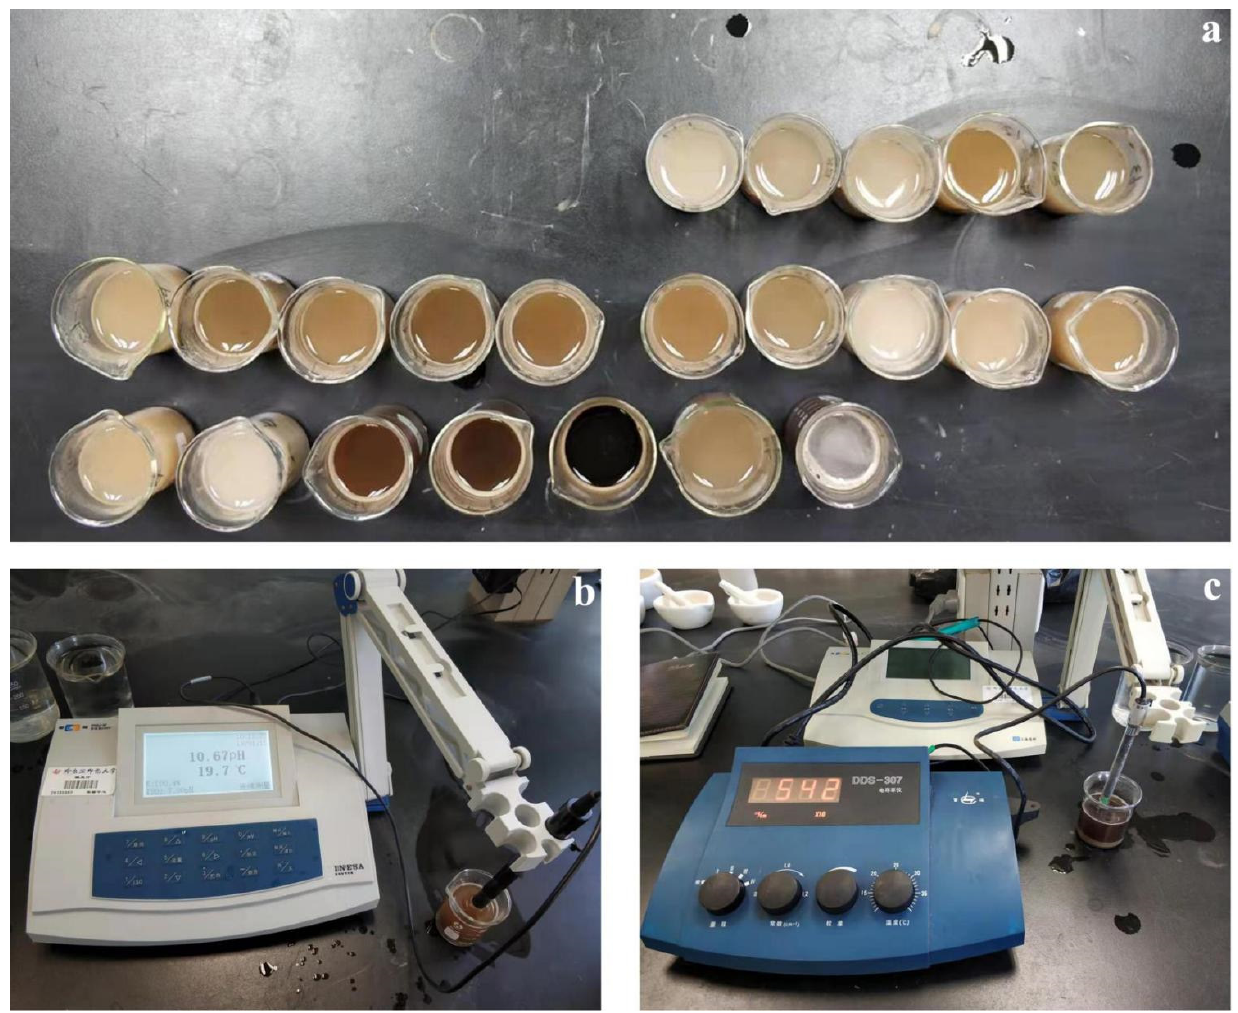
Figure 3. Measurements of main chemical soil properties. ( a ) Prepared soil suspensions; ( b ) pH measurement process; ( c ) EC measurement process.